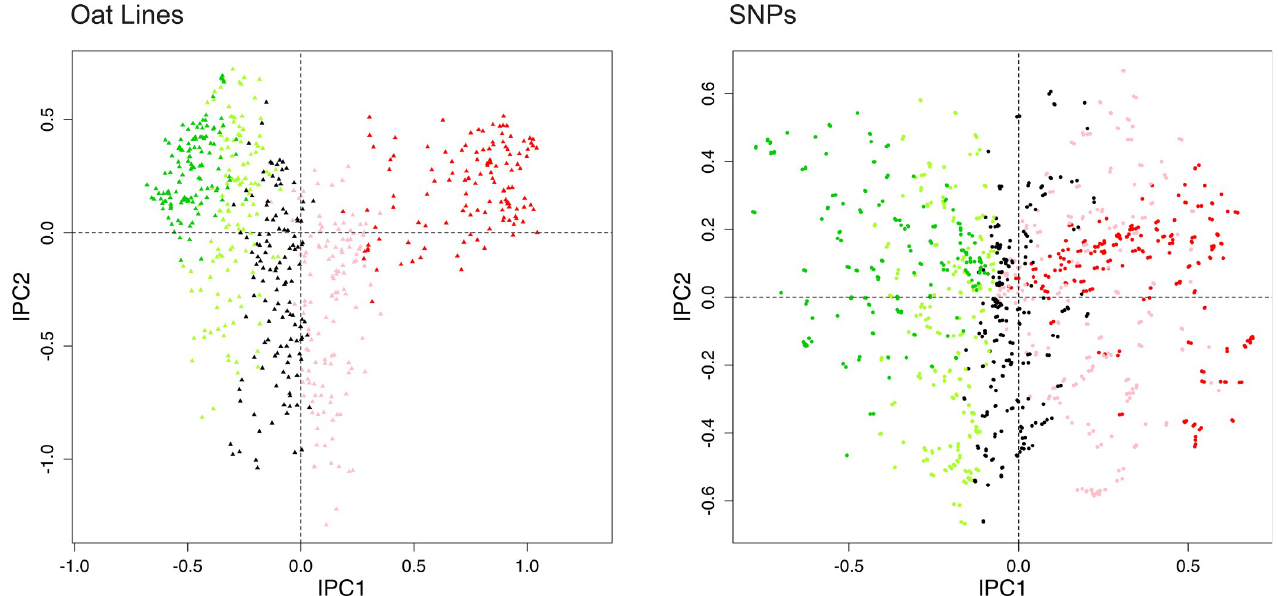
Fig 3. DC-PCA biplot for the oat data, using SNP coding rare = 1 and automated statistical analysis providing CA1 order. On the left, the 635 oat lines are subdivided into 5 equal groups according to CA1 order from top to bottom (spring to winter oats) in Fig 2, and these groups are colored dark green, light green, black, pink, and red. On the right, the same is done for the 1341 SNPs from left to right in Fig 2.